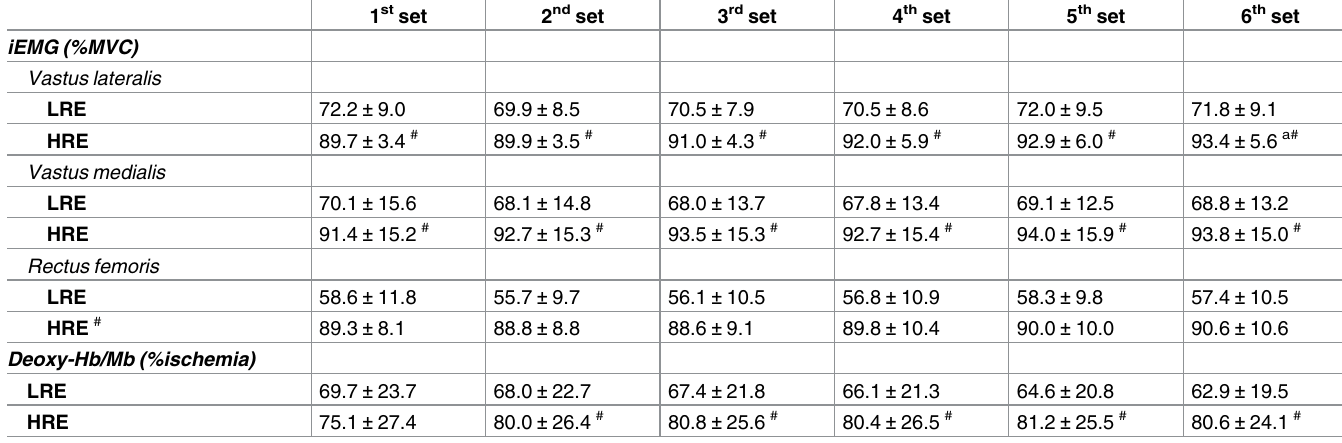
Table 3. Changes in skeletal muscle responses during